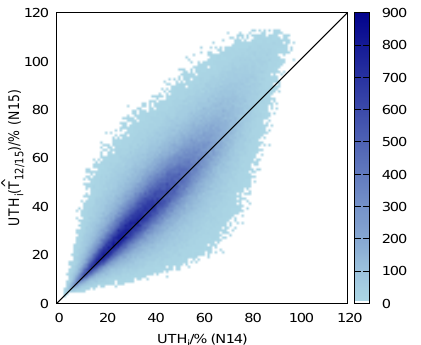
Figure 10. Heat map displaying UTHi computed using ˆ T 12 / 15 on the ordinate against values computed from the original T 12 / 14 on the abscissa. Obviously the problem concerning the excess of su- persaturation cases in the NOAA 15 data remains even with this new kind of data treatment. The colour scale shows the number of events in each 1% × 1%